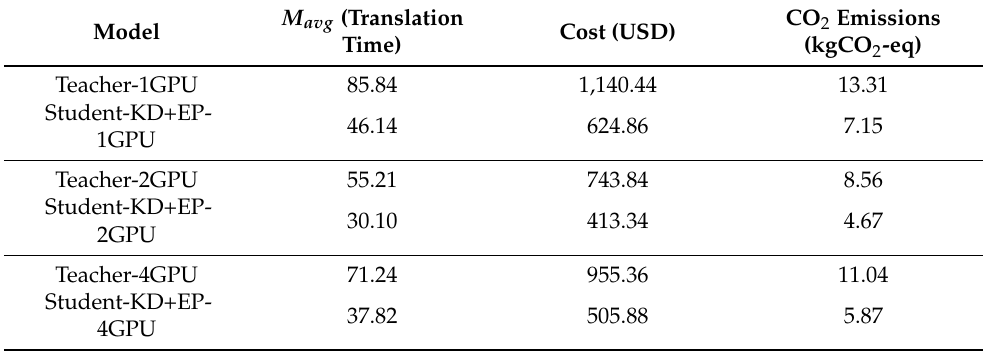
Table 11. Comparison of Cost in USD and CO 2 emissions of each model when translating M avg amount of words per month. The Translation time in hours is an estimate only. M avg (Translation CO 2 Emissions Cost (USD) Model (kgCO 2 -eq) Time)